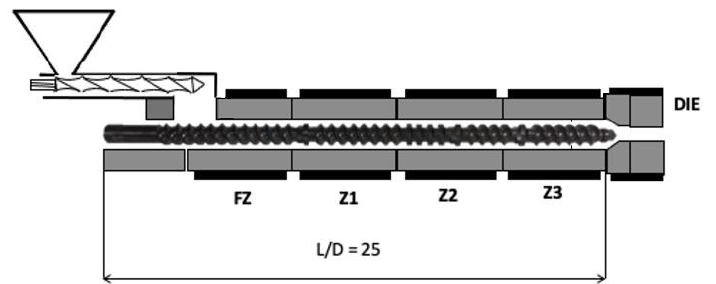
Figure 1. Extrusion layout: the screws are composed of an initial transport zone at feeding zone (FZ), followed by the first set of mixing blocks at the beginning of Z1, a transport zone, plus an intensive mixing zone at Z2; at Z3, there is a small mixing zone in between transport ones. Table 2. Melt-extruded PLA/multiwall carbon nanotube (MWCNT)/ poly(propylene) glycol (PPG) composites.